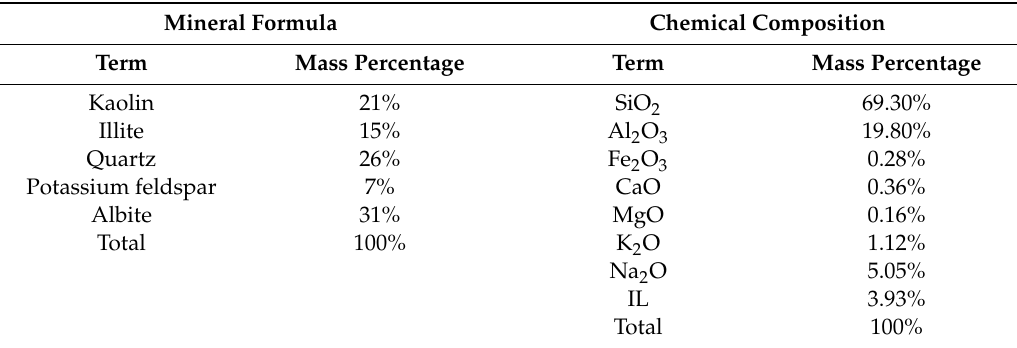
Table 7. Mineral formula and chemical composition of the unfired